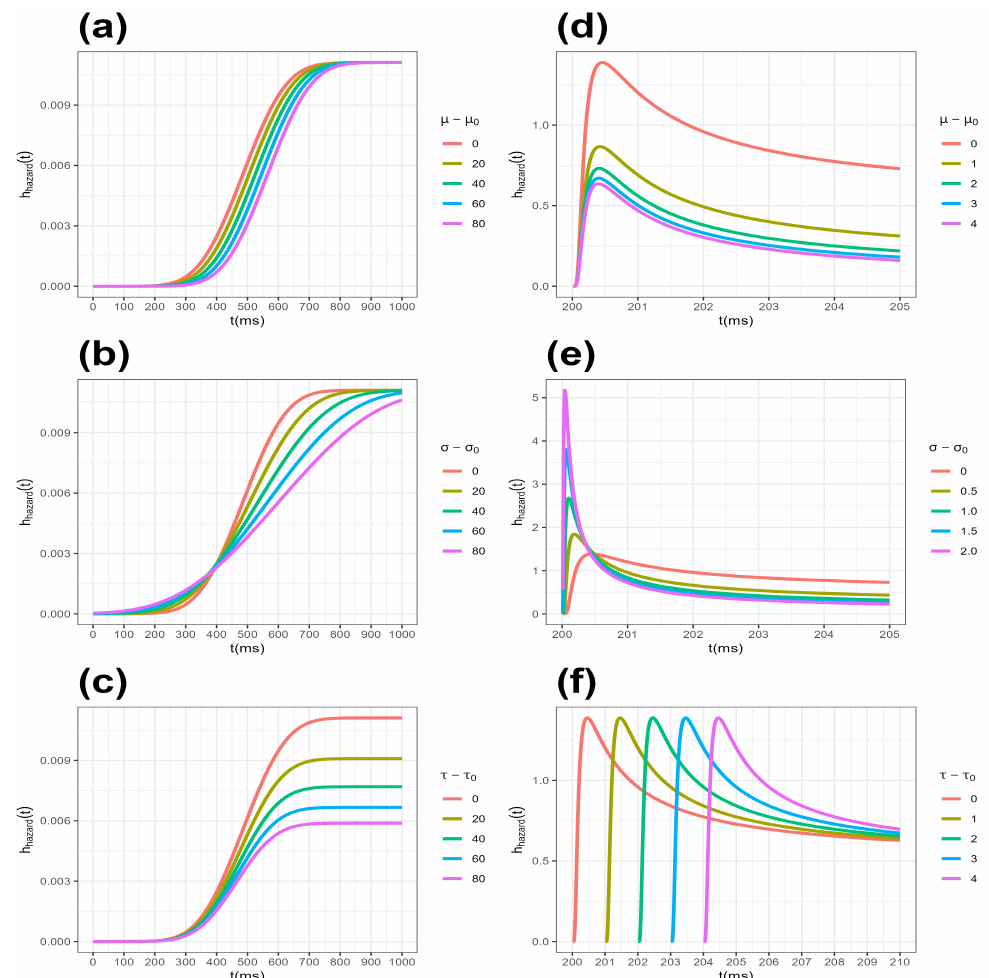
Figure 2. ( a – c ) ExG distribution hazard function change by parameters given µ 0 = 440, σ 0 = 90, τ = 90; ( d – f ) SW distribution hazard function change by parameters given µ 0